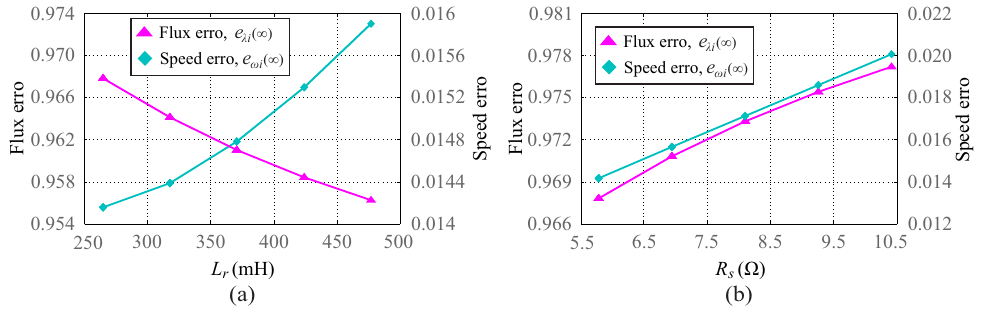
Figure 8. Flux and speed error values for ( a ) L r variations and ( b ) R s